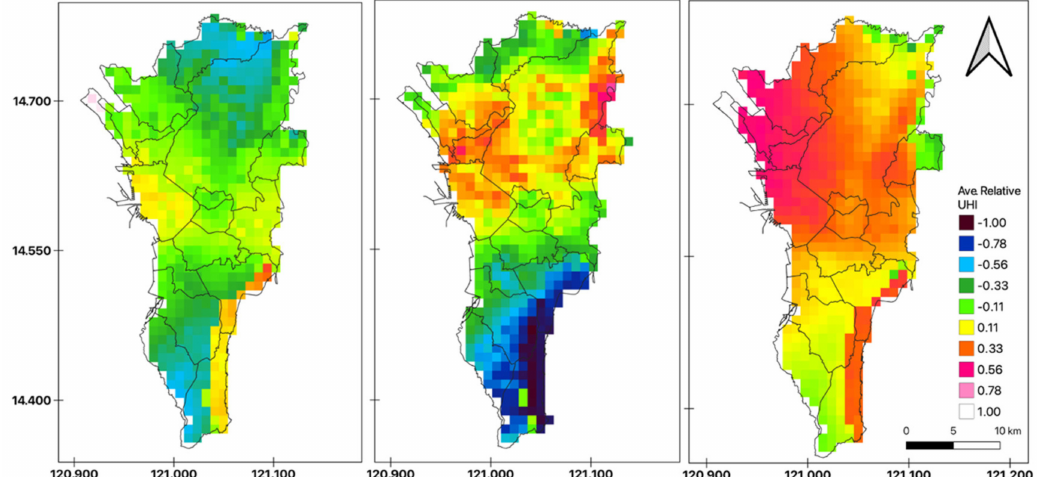
Figure 5. Average relative urban heat intensity in metro Manila. Positive values correspond to hot spots, while negative values correspond to cold spots. 8:00 ( left ), 14:00 ( center ), 20:00 ( right